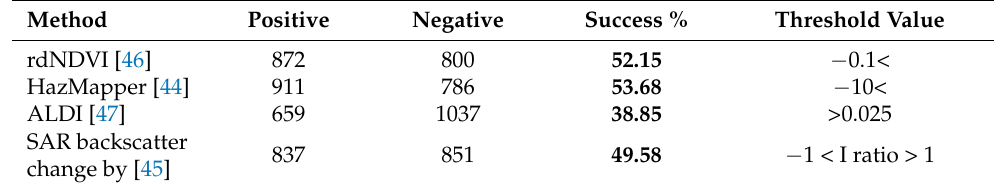
Table 2. Positive and negative detection of mapped landslides by the different change detection